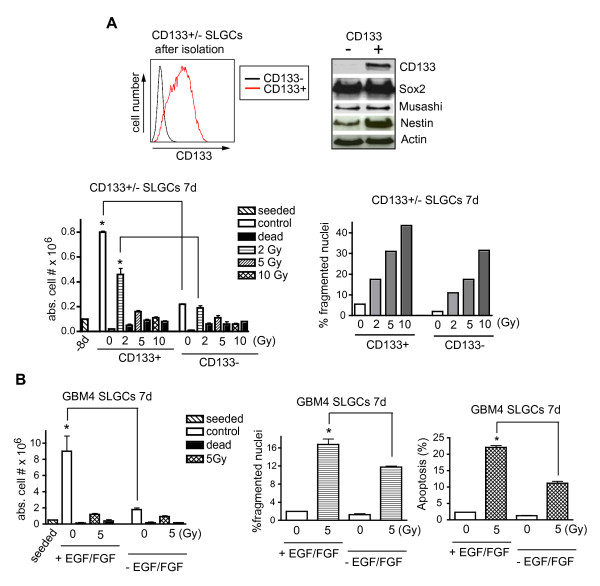
Correlation of proliferation with γIR-induced mitotic catastrophe and late apoptosis in SLGCs. A. Analyses of CD133+ and CD133- immature glioma cells. Flow cytometry analysis of CD133 expression in magnetic bead-separated CD133+/CD133-populations of GBM8 SLGCs (upper left). Expression of CD133, Sox2, musashi and nestin as determined by Western blotting (upper right). Viable and dead cells (lower left) and cells with signs of mitotic catastrophe (lower right) 7 d after irradiation. B. Influence of EGF plus FGF-2 on proliferation, mitotic catastrophe, and apoptosis of GBM4 SLGCs. The cells were incubated with or without EGF plus FGF-2 (20 ng/ml). After 24 h the cells were irradiated, and 7 d later analyzed. In the cytokine-treated cultures, EGF and FGF-2 were replenished after 3 days. Mean ± S.D. of at least three experiments is shown; statistical significance (p < .05).